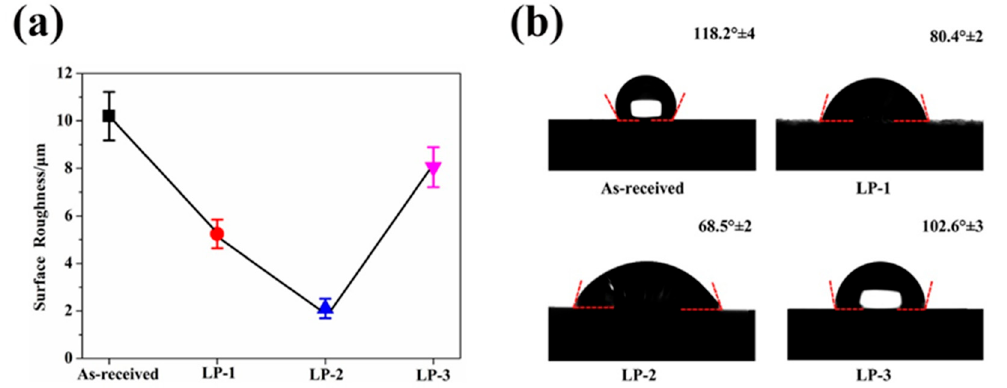
Figure 4. ( a ) Surface roughness obtained from LSCM and ( b ) the contact angles of samples.